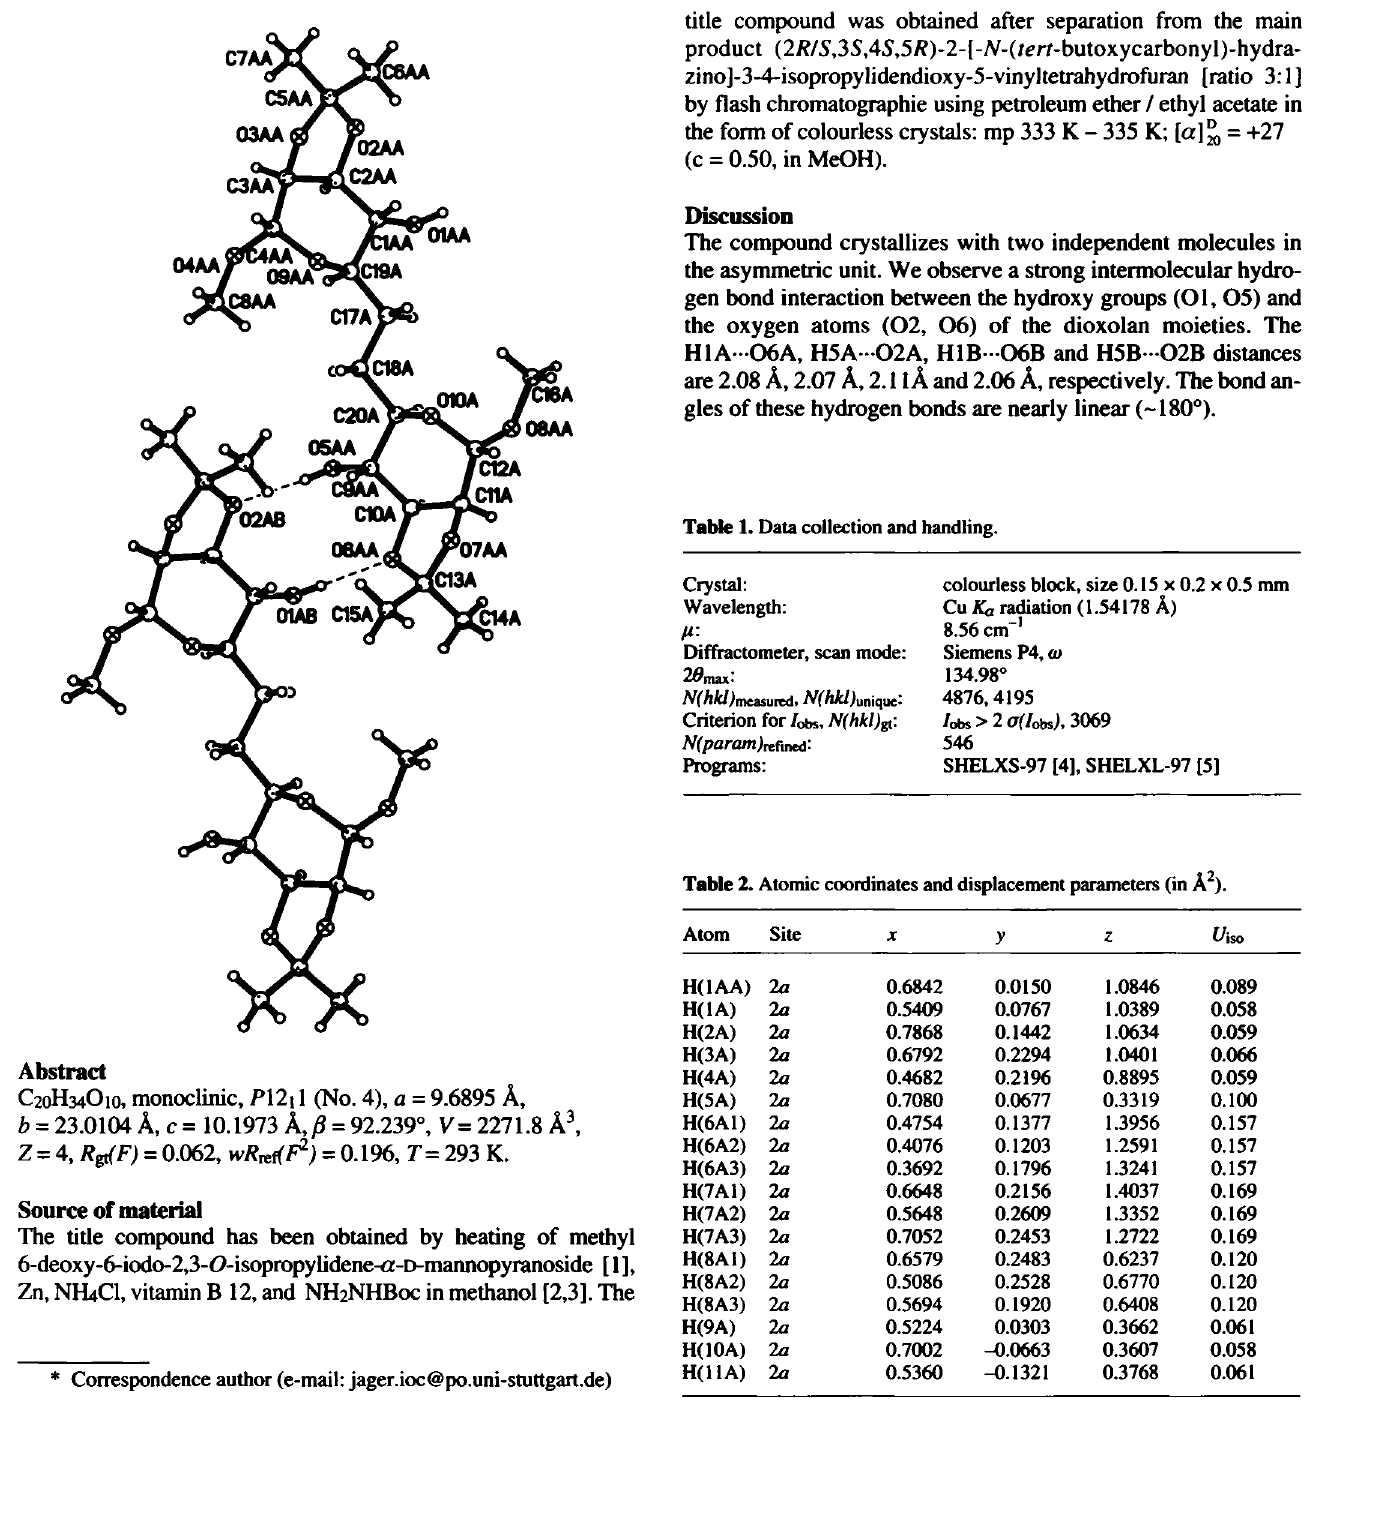
Table 1. Data collection and handling.